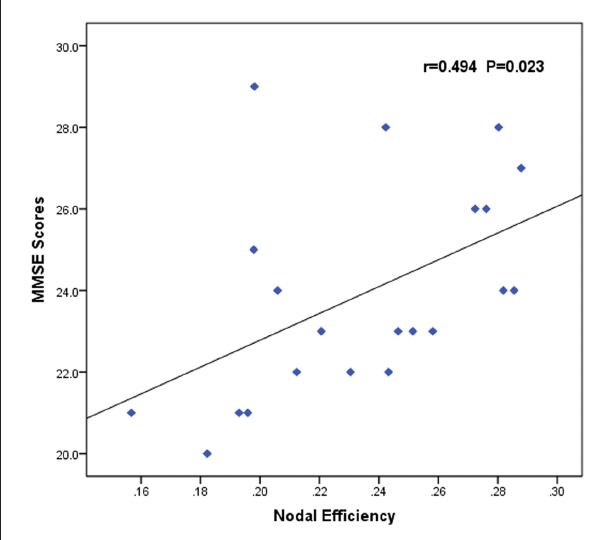
FIGURE 4 | Correlation between abnormal brain functional networks and clinical variables of the AUD group. Scatter plots of the nodal efficiency of the left OFC against the MMSE scores ( r = 0.494, p = 0.023). AUD, alcohol use disorder; OFC, orbitofrontal cortex; MMSE, Mini-Mental State